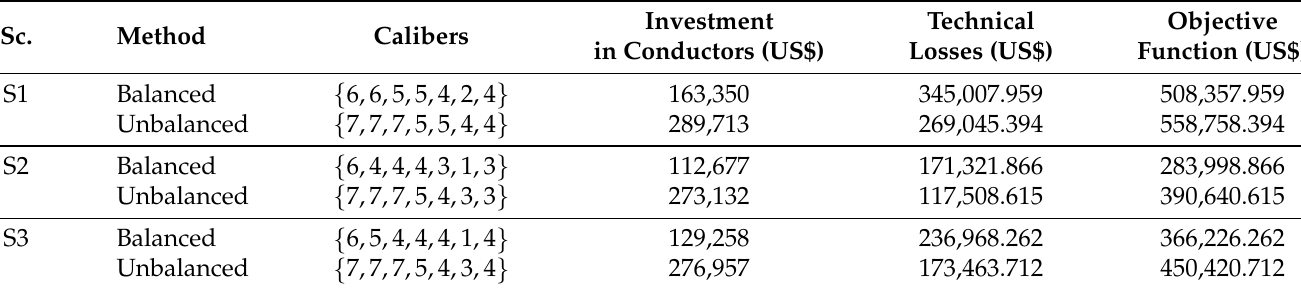
Table 23. Analysis of the 8-bus system with the DVSA approach for Y load connections.